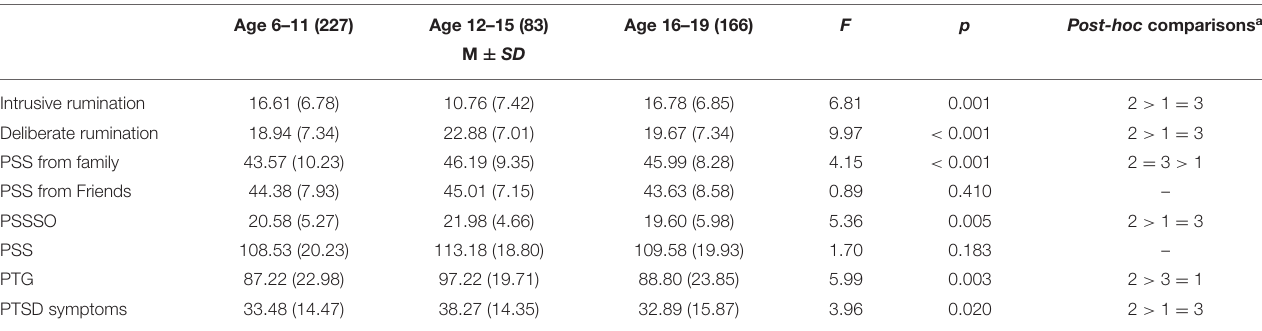
TABLE 1 | Means, standard deviations, and differences of variables of 2008 Wenchuan earthquake youth survivors by age ( n =